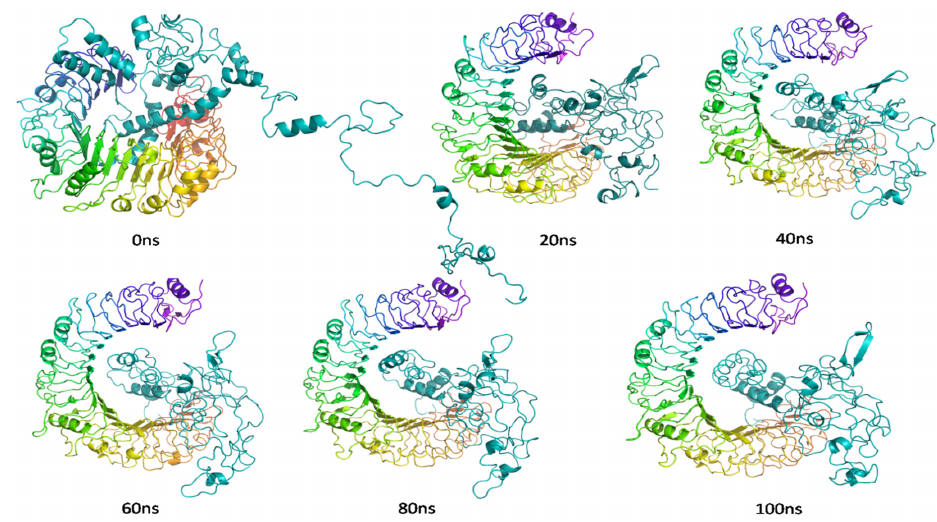
Figure 11. Snapshot of MD trajectories at different time interval for visualization of ligand–protein chain conformational changes into the binding cavity of protein chain.